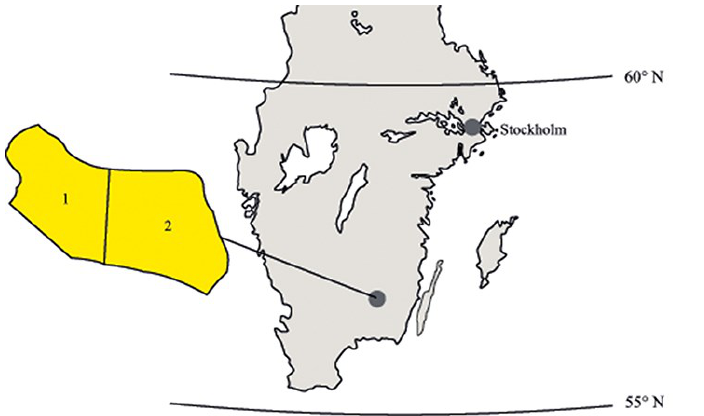
Figure 1. The location of the experimental clear-felled area in southern Sweden, divided into two parts used for the study. Logging residues were fresh-stacked in area 1 and dried-stacked in area